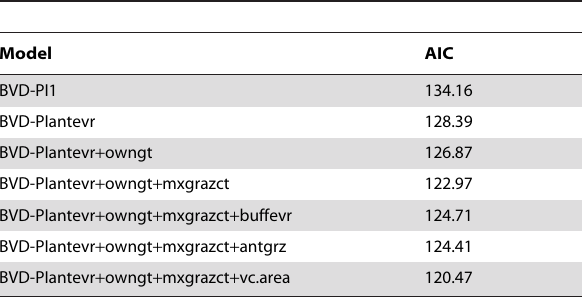
Table 2. Comparison of herd-level logistic regression risk factor models for presumed BVD PI in herd.